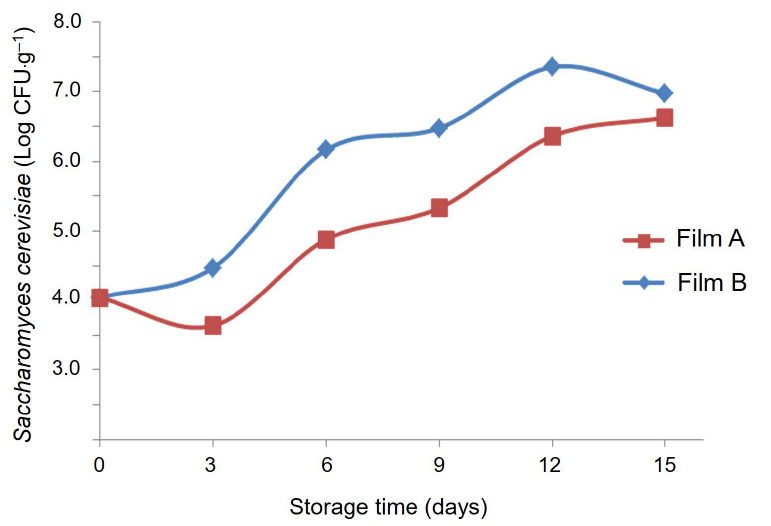
Figure 5. Saccharomyces cerevisiae count, in log CFU·g −1 , as a function of time, in Minas cheese stored at 4 °C for 15 days and packaged with methyl cellulose/poly (vinyl alcohol) blend films incorporated with 2% of natamycin and 5% of cellulose nanocrystals (Film A) and 5% of CNC (Film